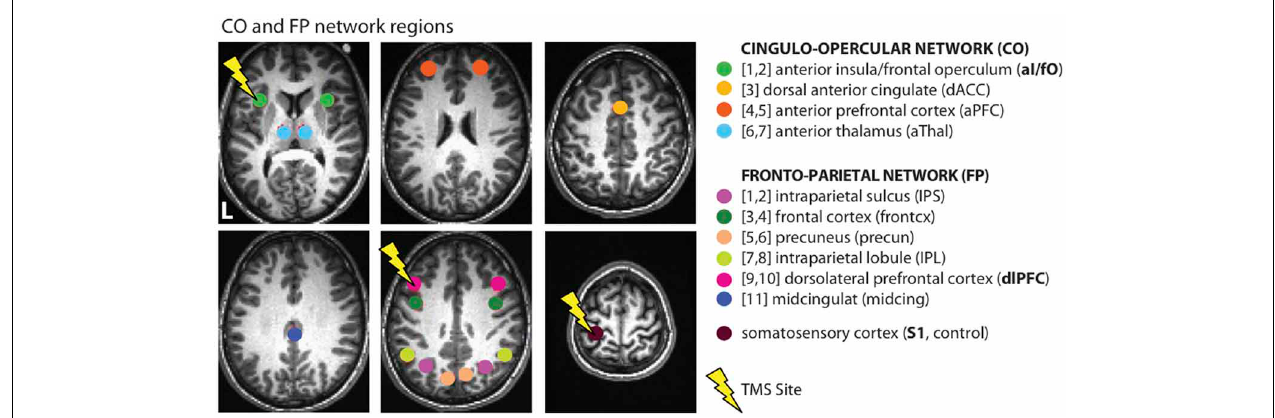
FIGURE 1 | Cognitive control networks. Connectivity was examined across and within regions from the CO and FP cognitive control networks, as defined in Dosenbach et al. (2007). These measurements were taken before and after TBS to L dlPFC (a region in the FP network), L aI/fO (a region in the CO